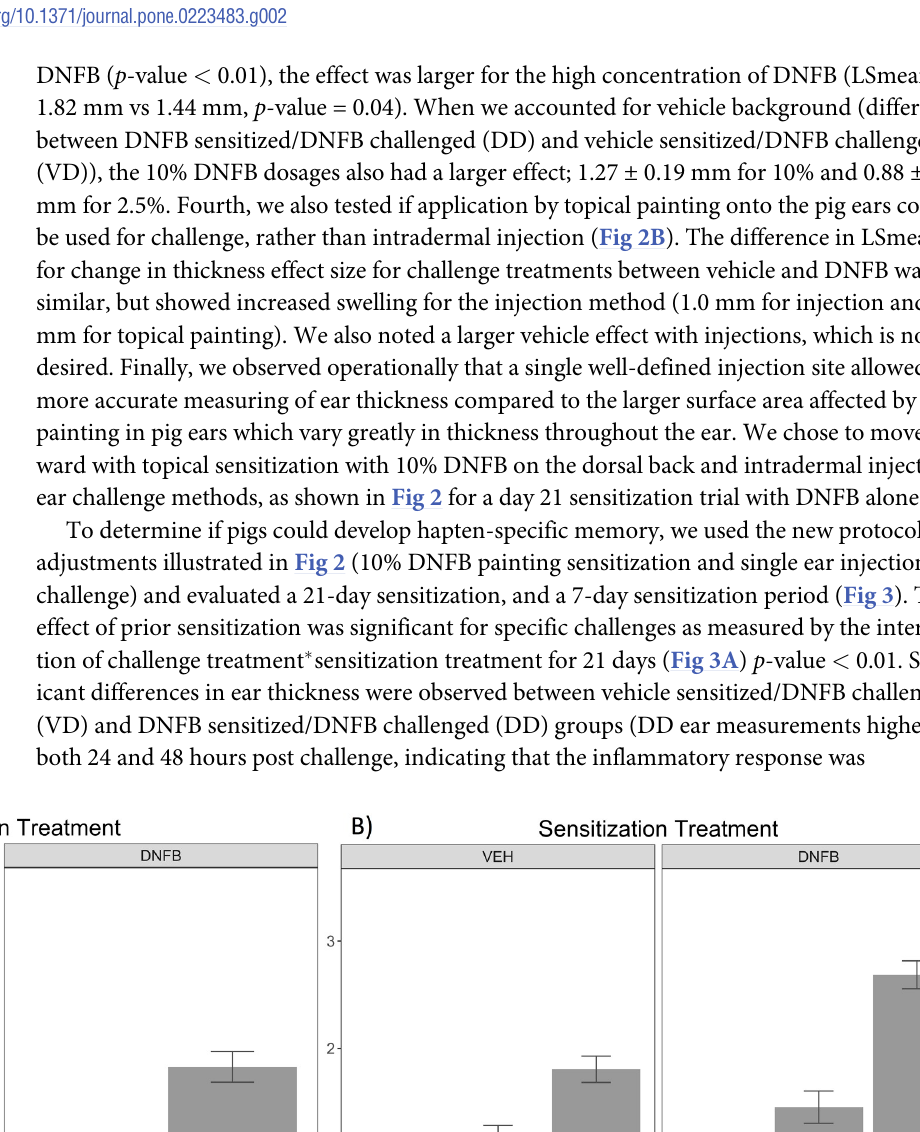
Fig 2. Improvements to CHS protocol shows topical application of sensitizing agent causes less background inflammatory response with 21 day sensitization period. (A) Dosage comparison for sensitizing concentration of topical dorsal application (paint) of DNFB low (2.5%) versus DNFB high (10%). (B) Ear challenge methodology comparison between injection vs topical painting application across both sensitization concentrations after 48 hours post challenge. Error bars represent standard error.